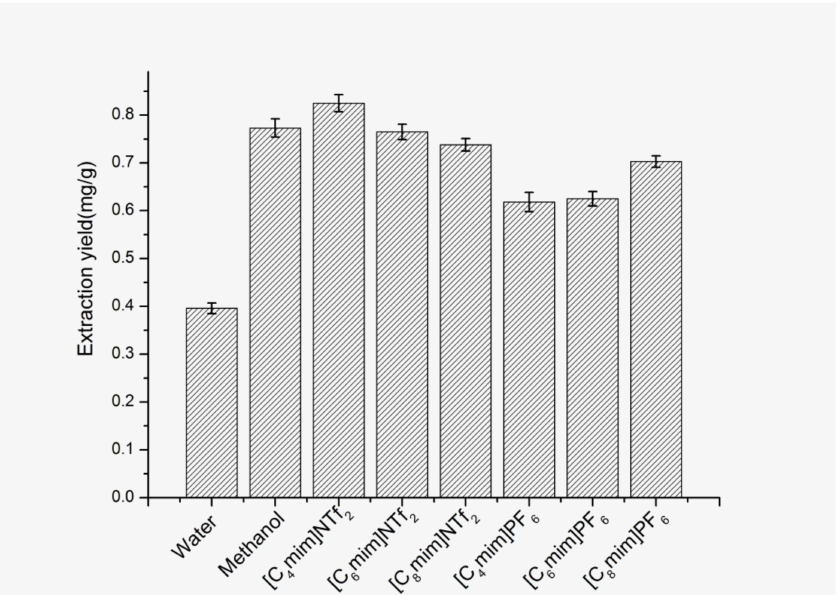
Figure 5. E ff ect of di ff erent extraction solvents on extraction yield of FA. Sample amount, 50 mg; volume of IL, 0.8 mL; extraction temperature, 60 ◦ C; solid–liquid ratio, 1:40 (g / mL); ultrasonic time, 9 min; centrifugal speed, 11,000 rpm; centrifugal time, 5